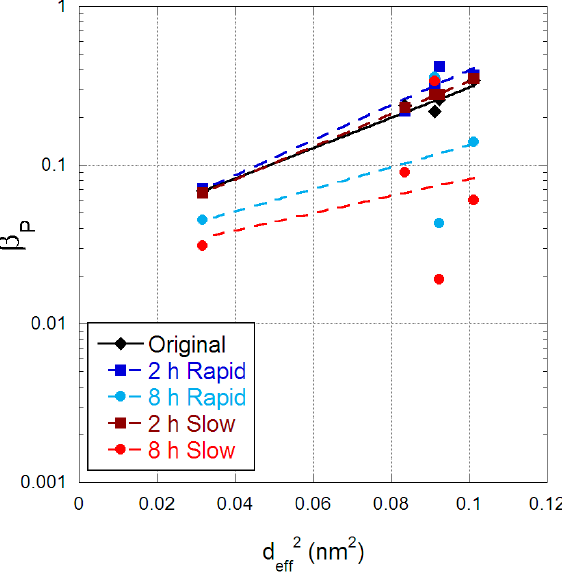
Figure 8. Aging rate constant for PIM-1 membranes as a function of the square of the effective gas diameter (nm 2 ).